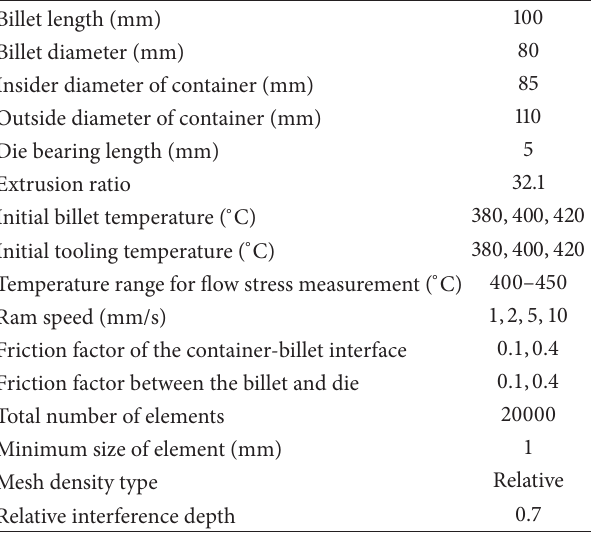
Table 2: Simulation and experimental parameters.